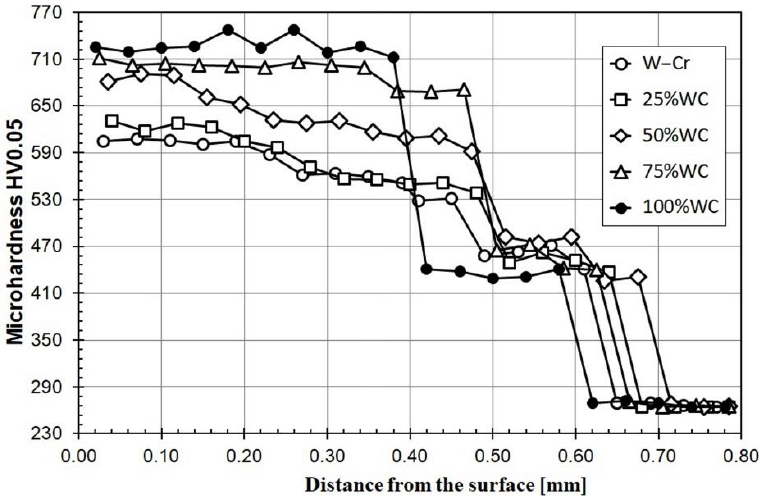
Figure 11. Microhardness of coatings produced using laser processing of different precoats applied on steel substrate (omitting the larger and unmelted WC particles) .